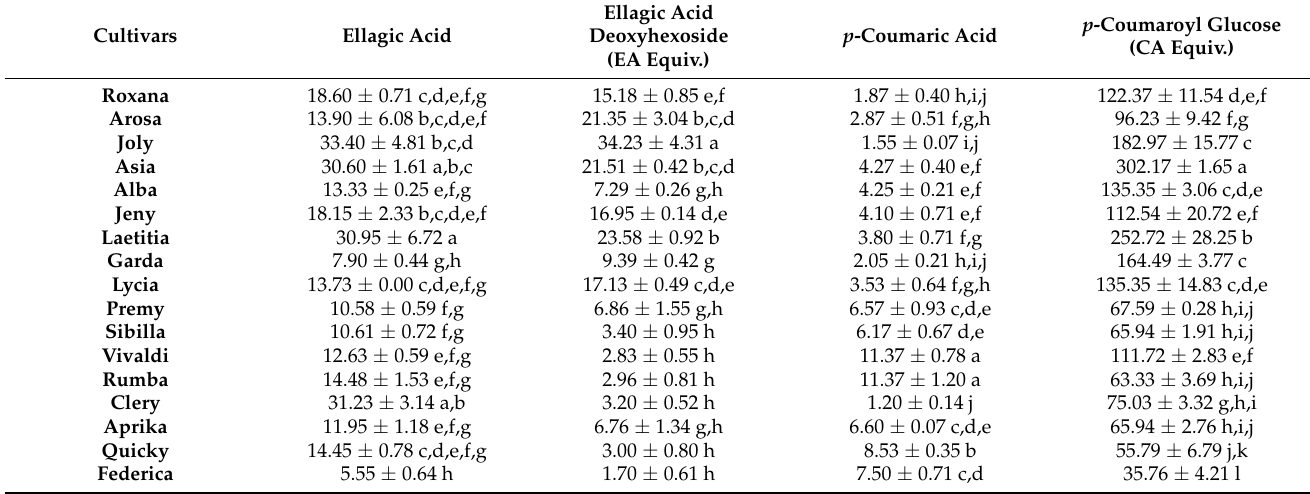
Table 4. Content ( µ g g − 1 of FW) of phenolic acids and their derivatives in strawberry fruit